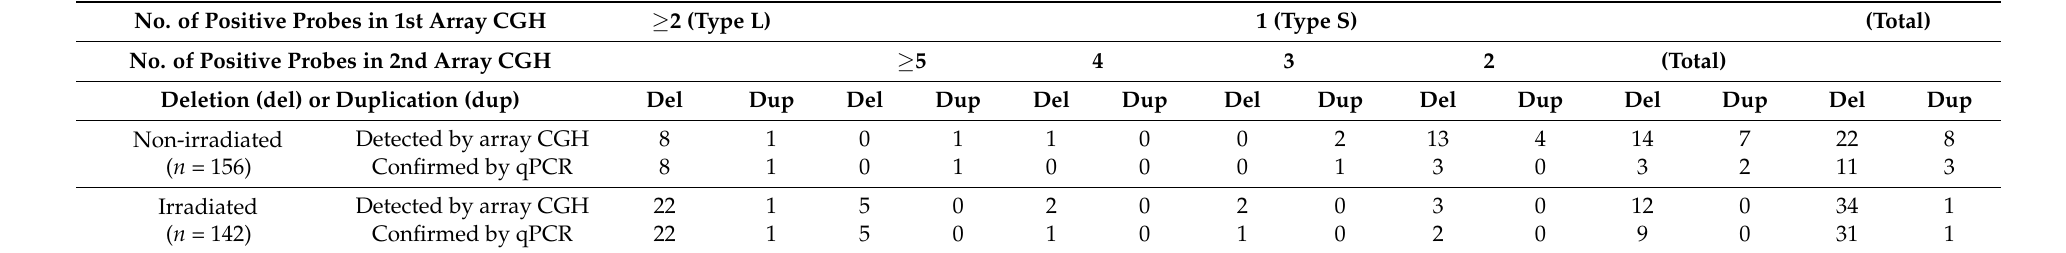
Table 2. Number of the (candidate) CNVs detected by array CGH and confirmed by